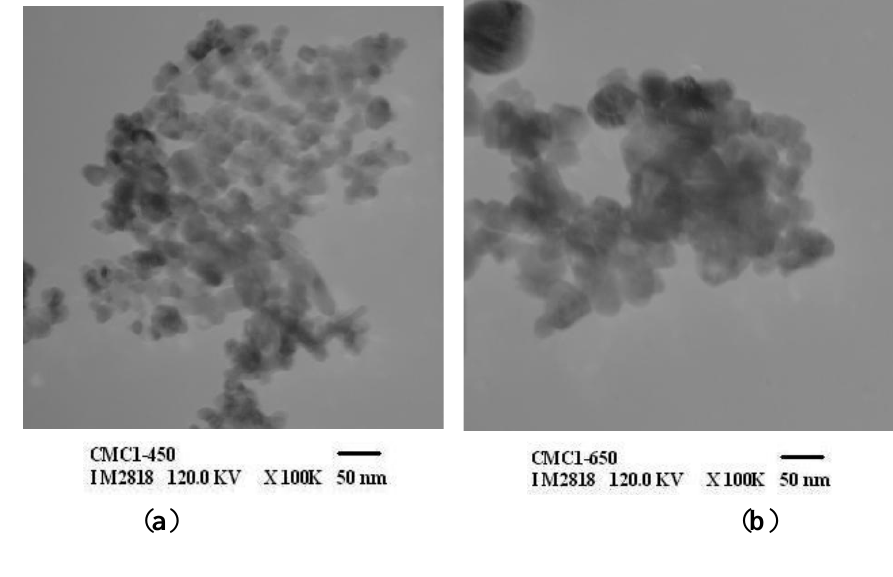
Figure6. TEM of ( a ) ZnO-CMC1-450; ( b ) ZnO-CMC1-650; and ( c )